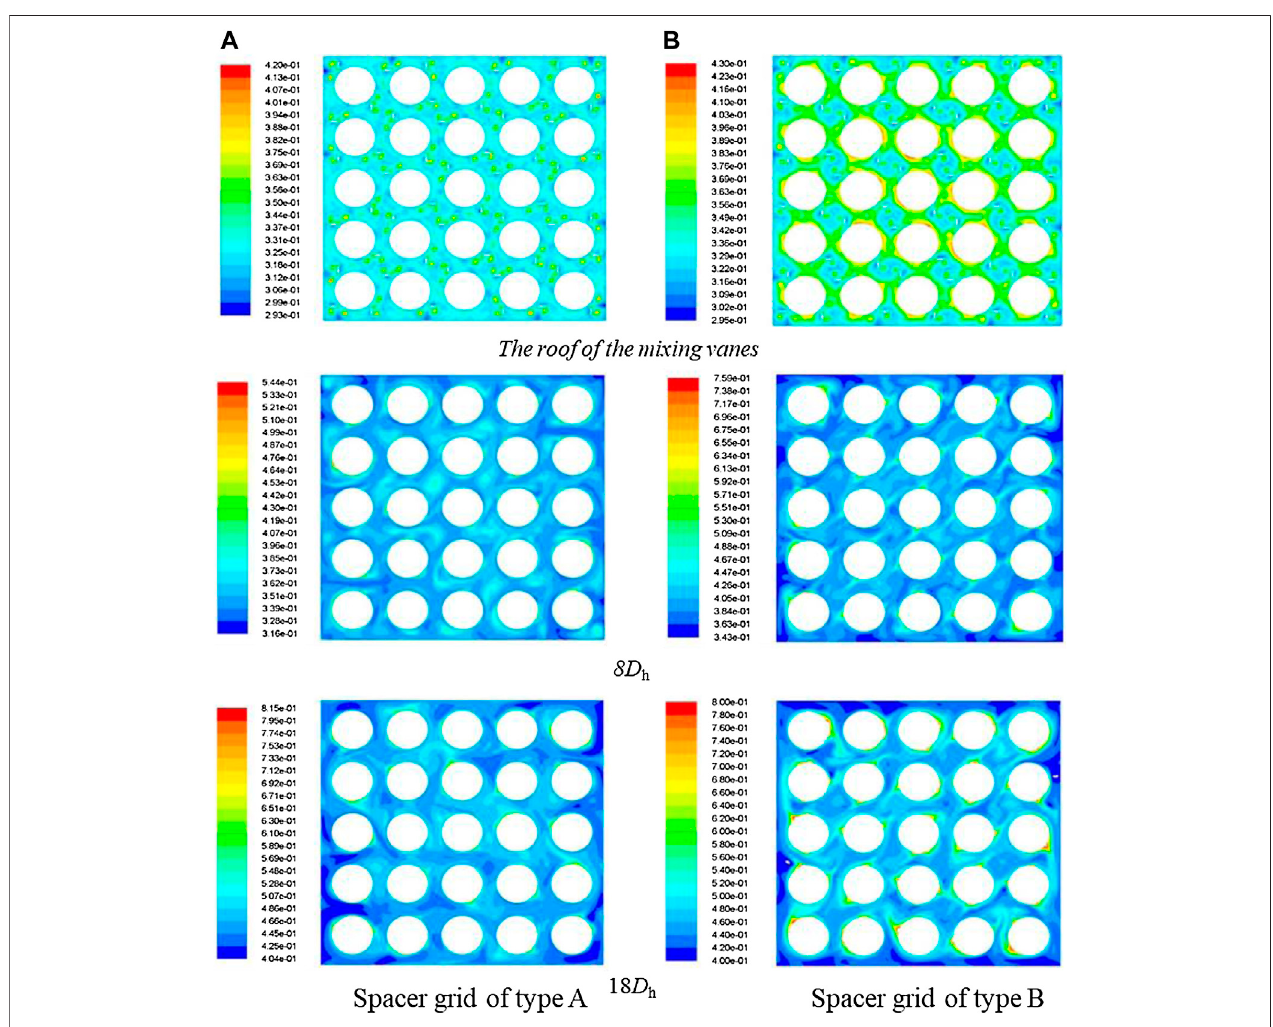
FIGURE 11 | Variations of vapor-phase distribution at different axial cross